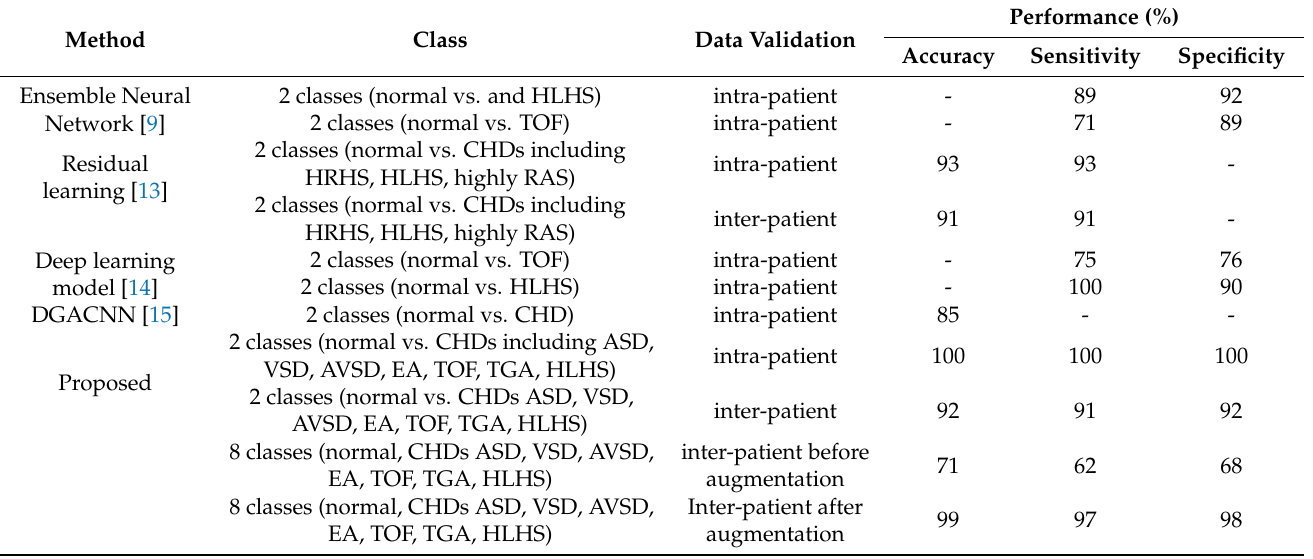
Table 8. Benchmarking with State-of-the-Art